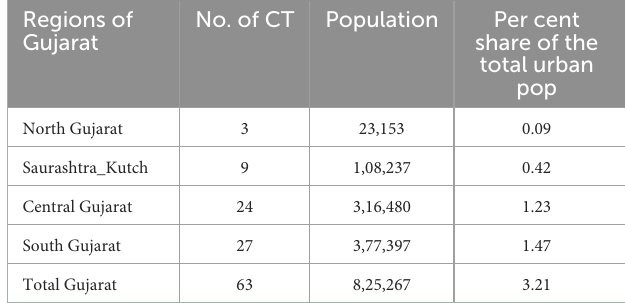
TABLE 9 Numbers and share of urban population in census towns of